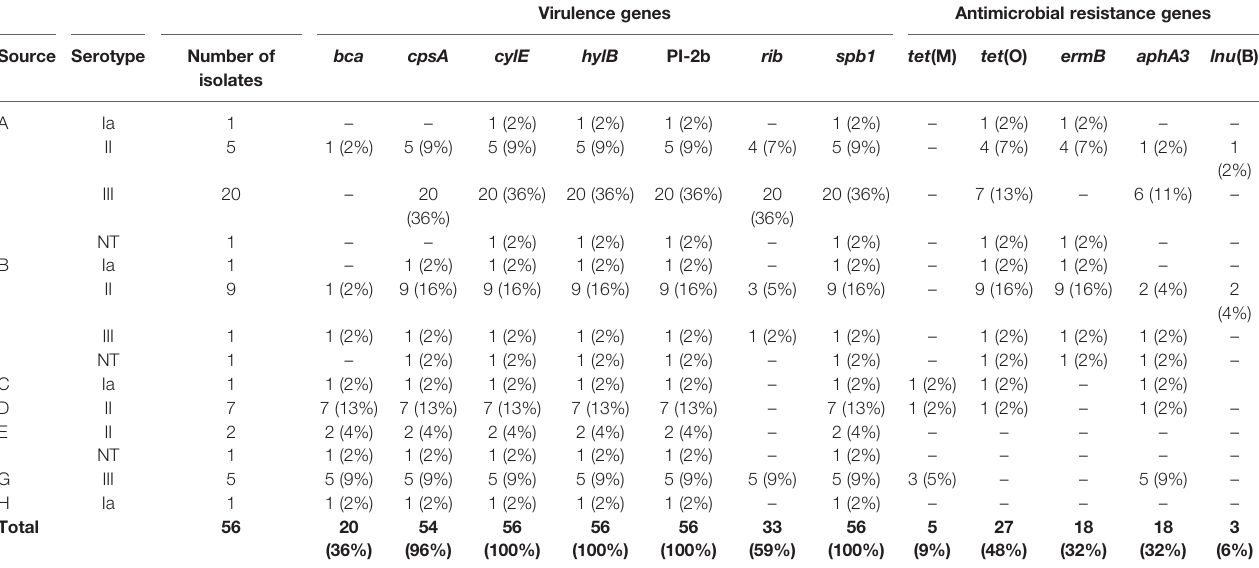
TABLE 2 | Distribution of virulence and antimicrobial resistance genes detected among Streptococcus agalactiae isolates recovered from dairy cattle with mastitis in